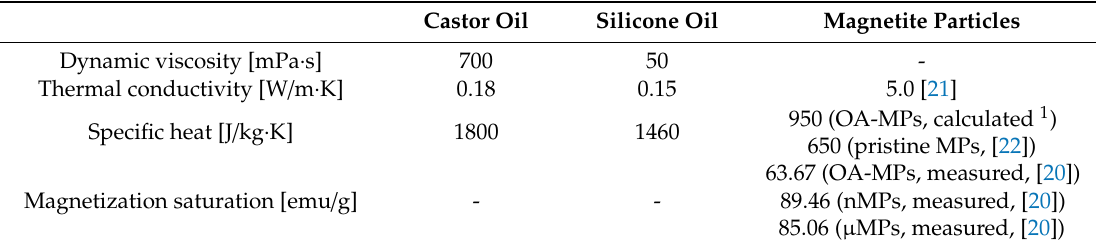
Table 1. List of physical parameters of materials used in the experiments. The values were given for room temperature. If not otherwise stated, the values were taken from data